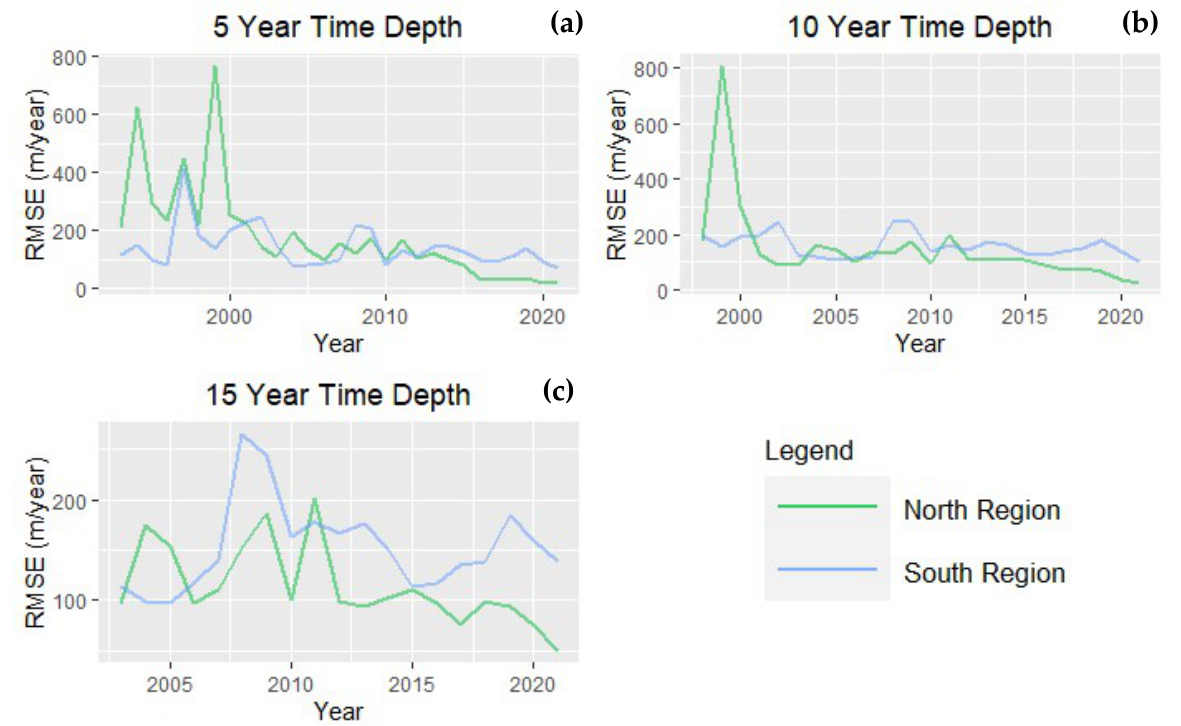
Figure 5. Variations in RMSE values calculated using the LRR rates data for predicting 1 year in the future: ( a ) 5 years’ time depth, ( b ) 10 years’ time depth, and ( c ) 15 years’ time depth.